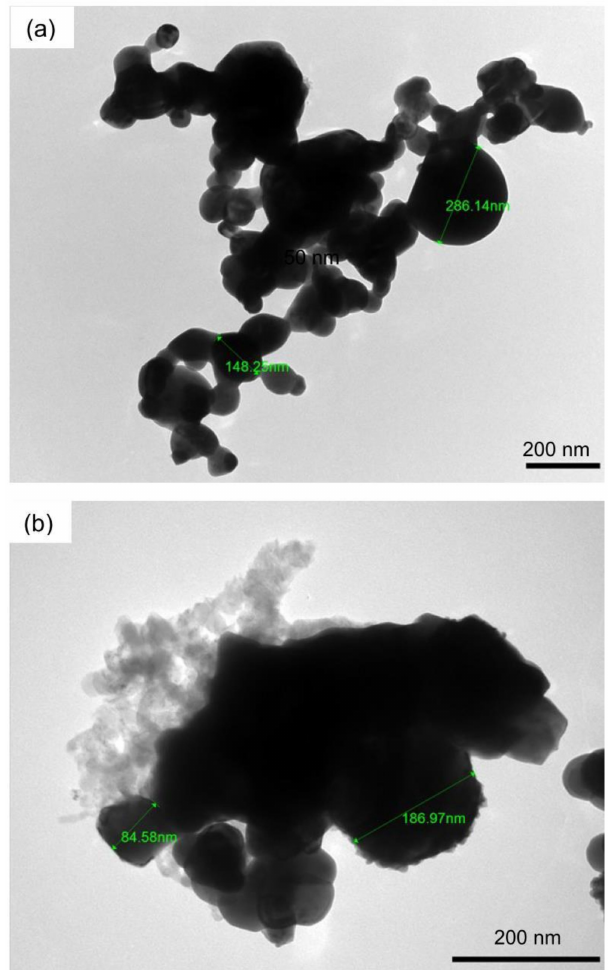
Figure 11. TEM image of spent NiMoRe/GDC catalyst ( a ) without H 2 S and ( b ) with H 2 S after 10 h of reaction at 800 ◦ C without H 2